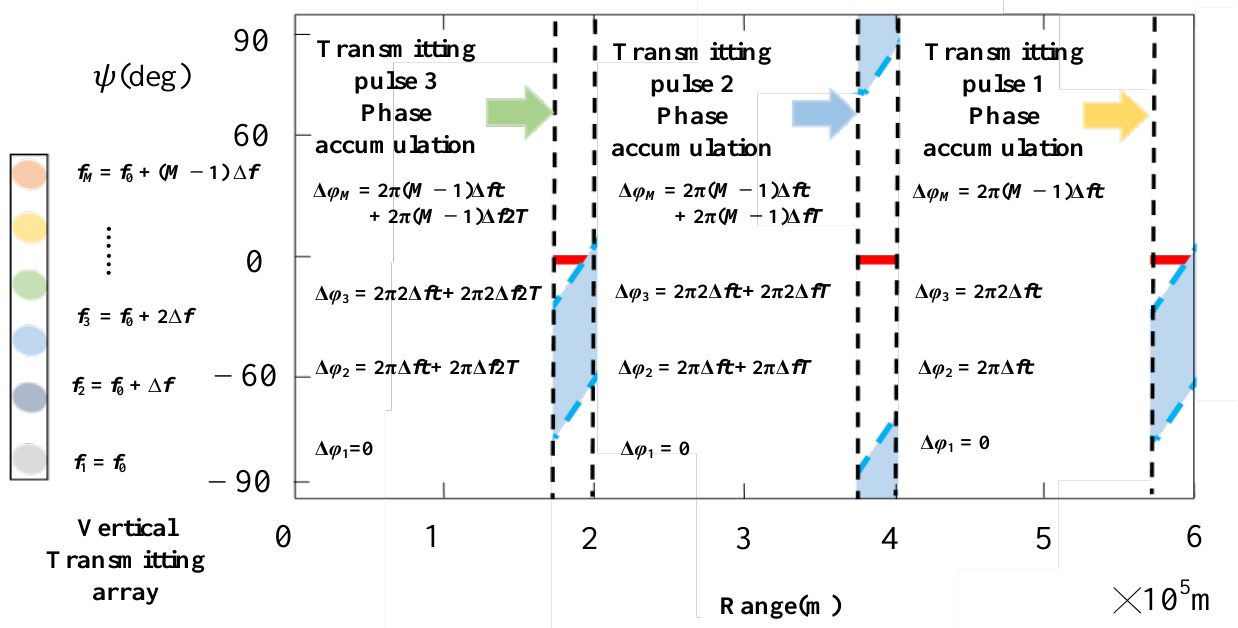
Figure 2. Schematic diagram of main lobe movement in equivalent transmission pattern.